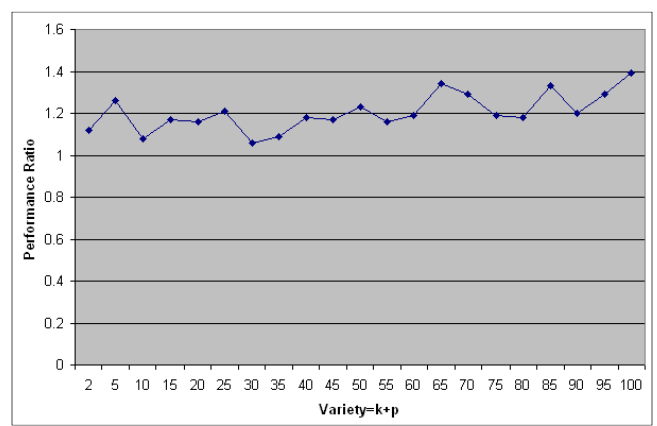
Figure 7. Performance ratio as a function of flow variety